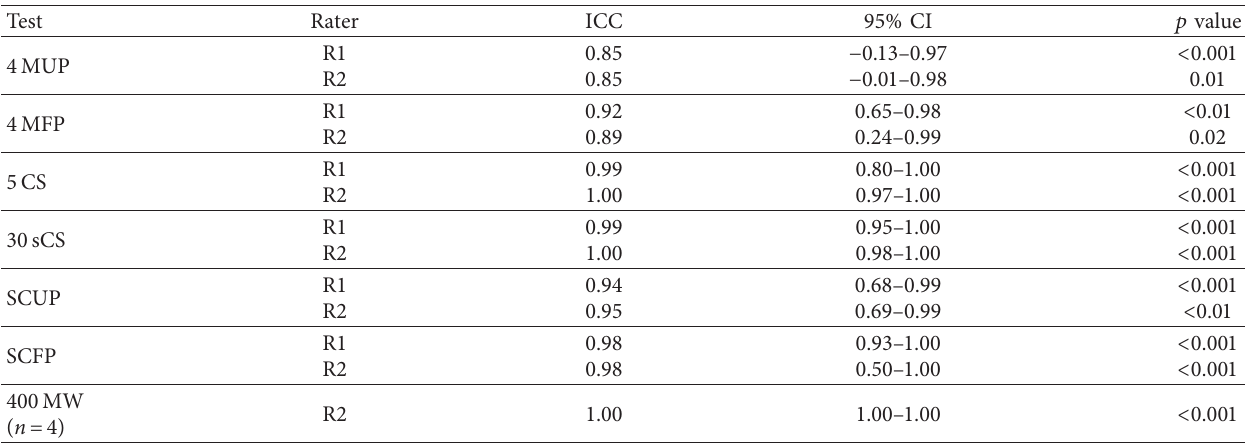
Table 4: Intrarater reliability of functional performance testing between video-recorded scores and live data collection for two raters for time point 1; rater 1 (R1): n � 9 participants; rater 2 (R2): n � 6